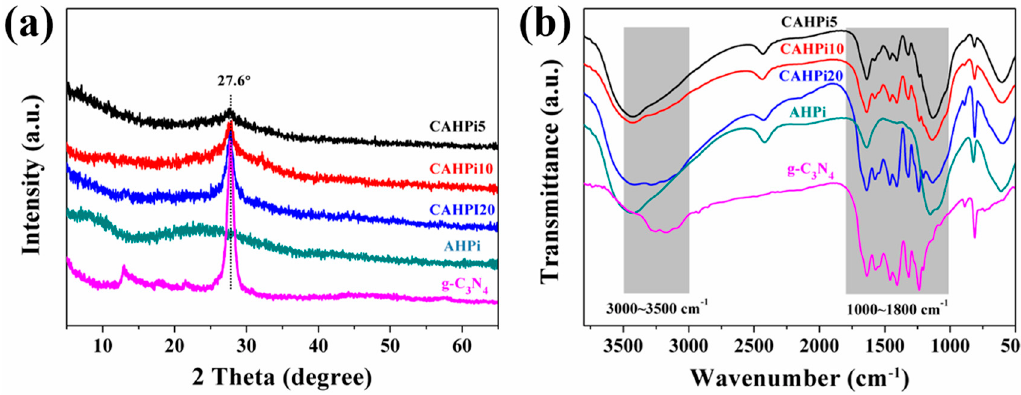
Figure 1. ( a ) X-ray diffraction (XRD) patterns and ( b ) Fourier transform infrared (FTIR) spectra of g- C 3 N 4 , aluminum hypophosphite (AHPi) and their hybrids.